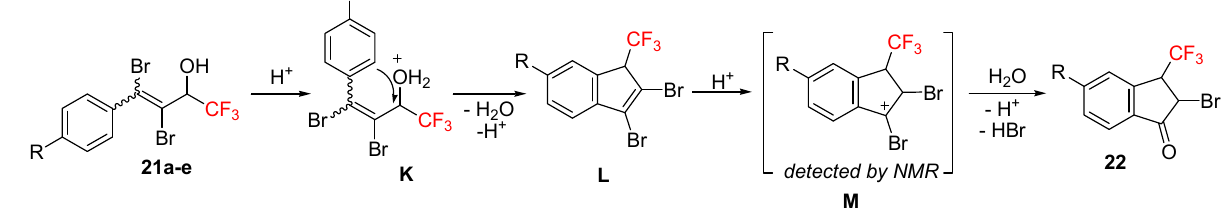
Scheme 17. Plausible mechanism of cyclization of dibromo-CF 3 -allyl alcohols 21a-e into CF 3 -indanones 22a-e in TfOH-CH 2 Cl 2 . Karpovet al., in their study on the synthesis and reactions of perfluorinated aromat-